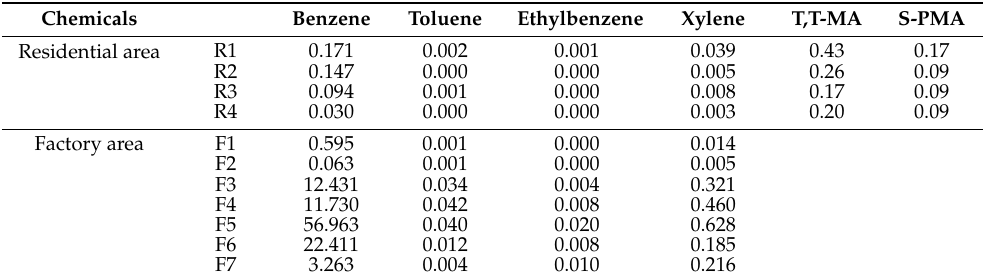
Table 4. Noncancer risk (HQ) of sampling sites in residential and factory